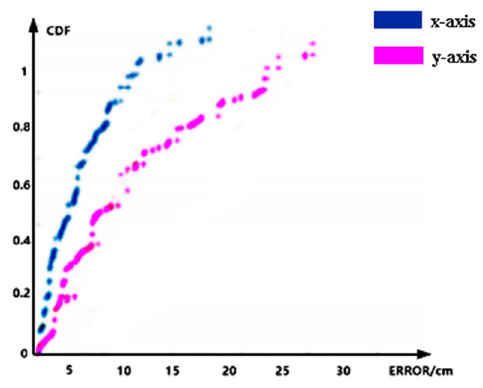
Figure 8. CDF of the errors of the horizontal position.